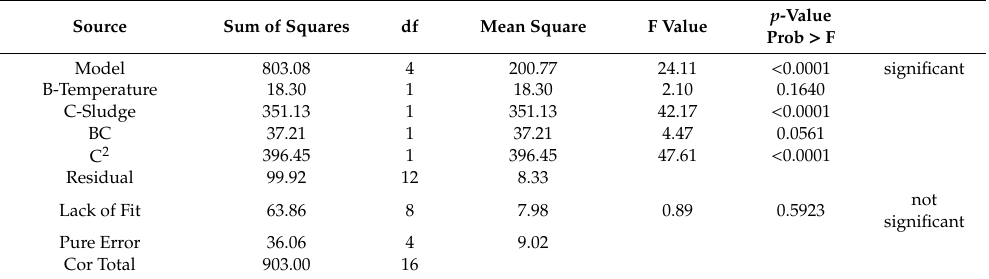
Table 16. ANOVA table for CO 2 % for AD of spent grain and pot ale quadratic model α = 0.05. Source Sum of Squares df